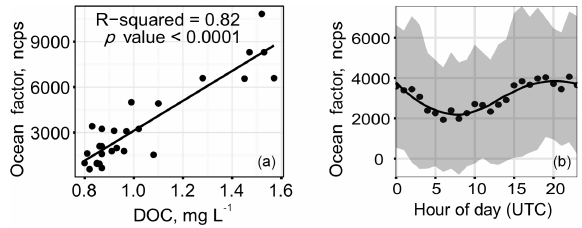
Figure 4. A large suite of oxygenated VOCs (OVOCs) were mea- sured on the CCGS Amundsen during the 2014 cruise in the high Canadian Arctic. A factor analysis of the full time-dependent data set yielded an “Ocean factor” of small organic acids whose inten- sity correlated with the DOC levels in the ocean (a) and with time of day and hence downwelling radiation (b) . See text for additional discussion. Figures from Mungall et al.